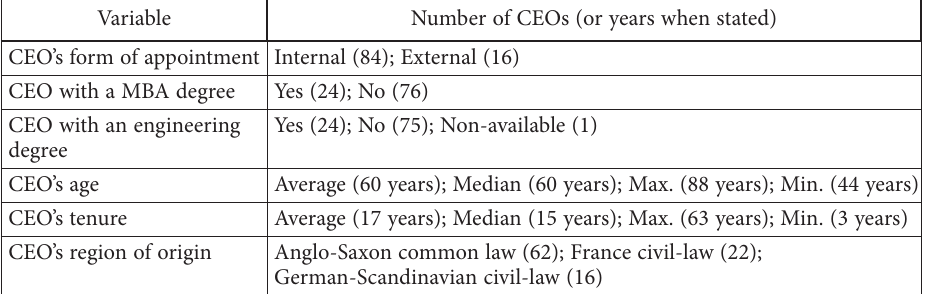
Table 3. Descriptive information for our sample